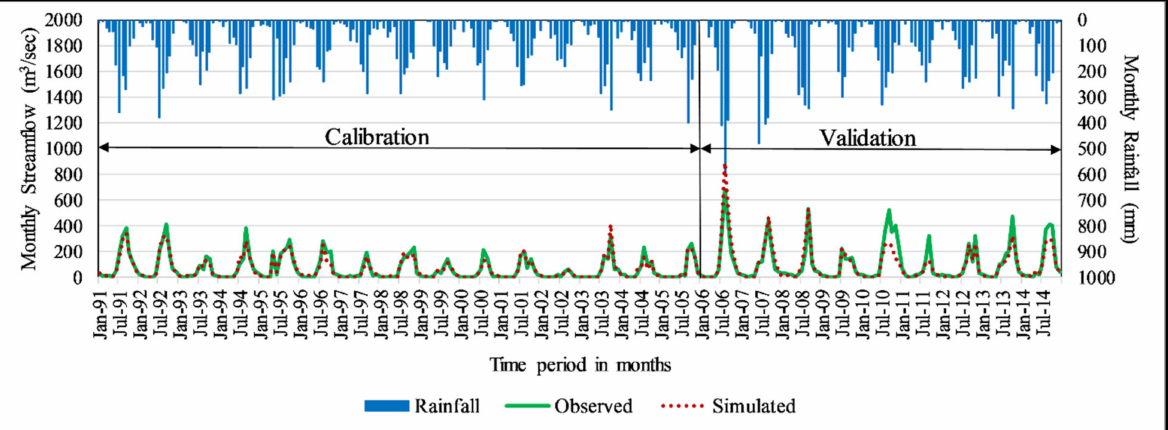
Figure 4. Observed versus simulated monthly streamflow during the calibration and validation period over the Nagavali river basin.